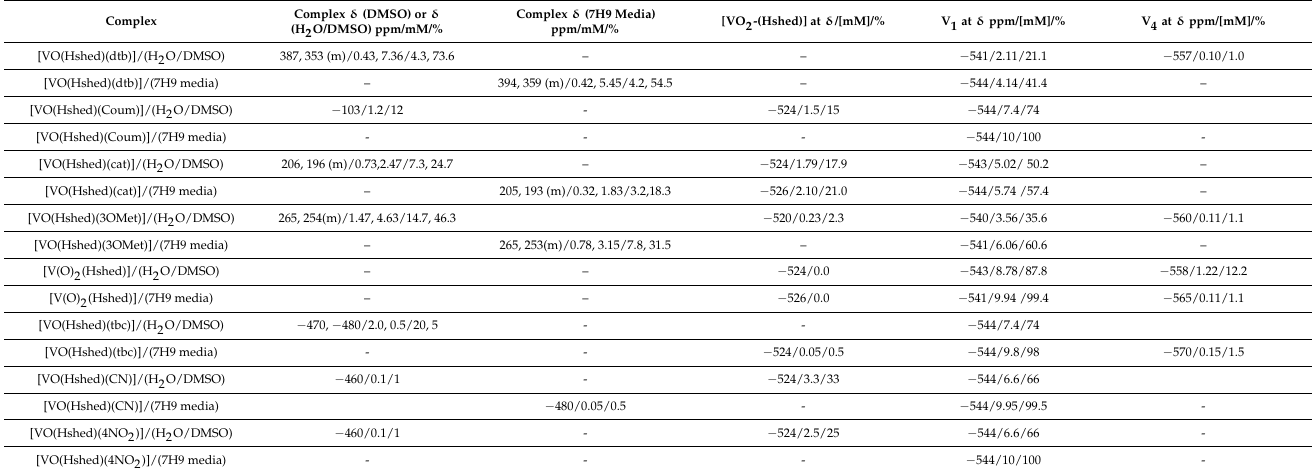
Table 4. Species observed for 10 mM Schiff base vanadium-catecholate complexes in the mixture solution (50:50 H 2 O:DMSO) and 50:50 7H9 growth medium:DMSO at t = 0